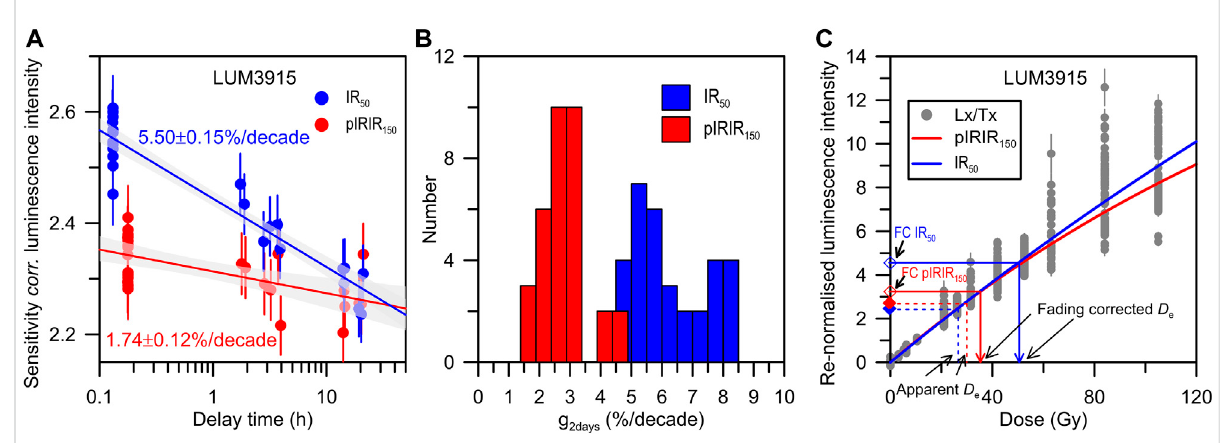
FIGURE 7 Results of fading correction. (A) The determination of the fading rates (g, %/decade) of IR 50 and pIRIR 150 signals for one representative sample, LUM3915. (B) The distributions of the g values of IR 50 and pIRIR 150 signals for all the samples. (C) The fading correction approach for the representative sample LUM3915 following Lamothe et al. (2003).